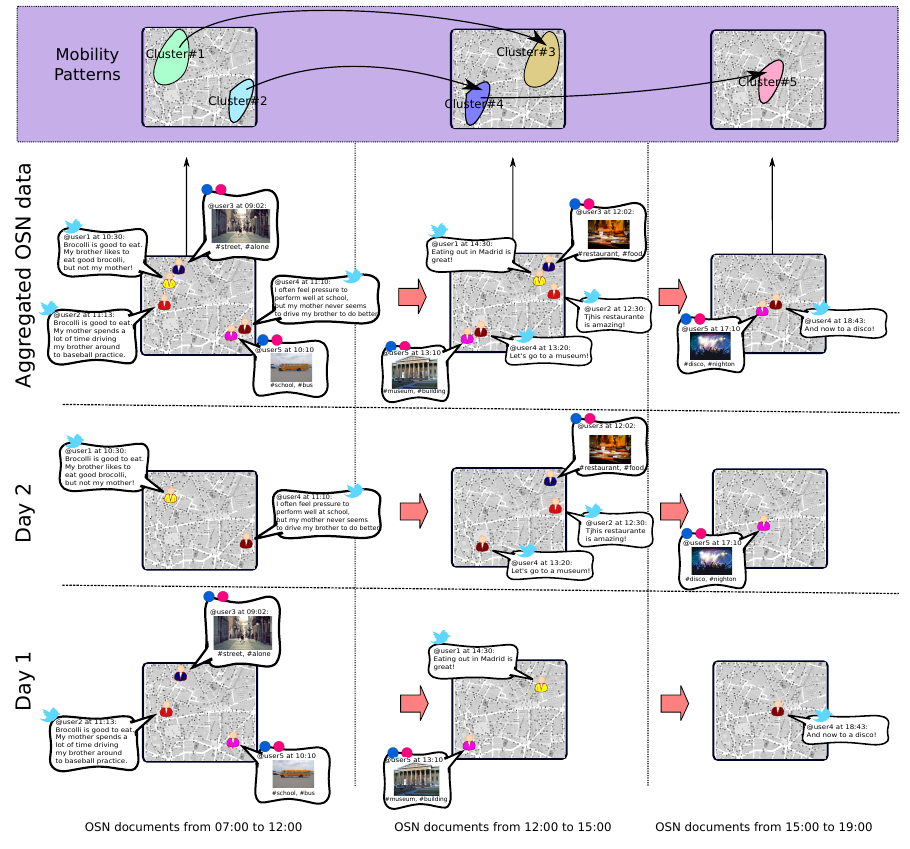
Figure 1. Approach